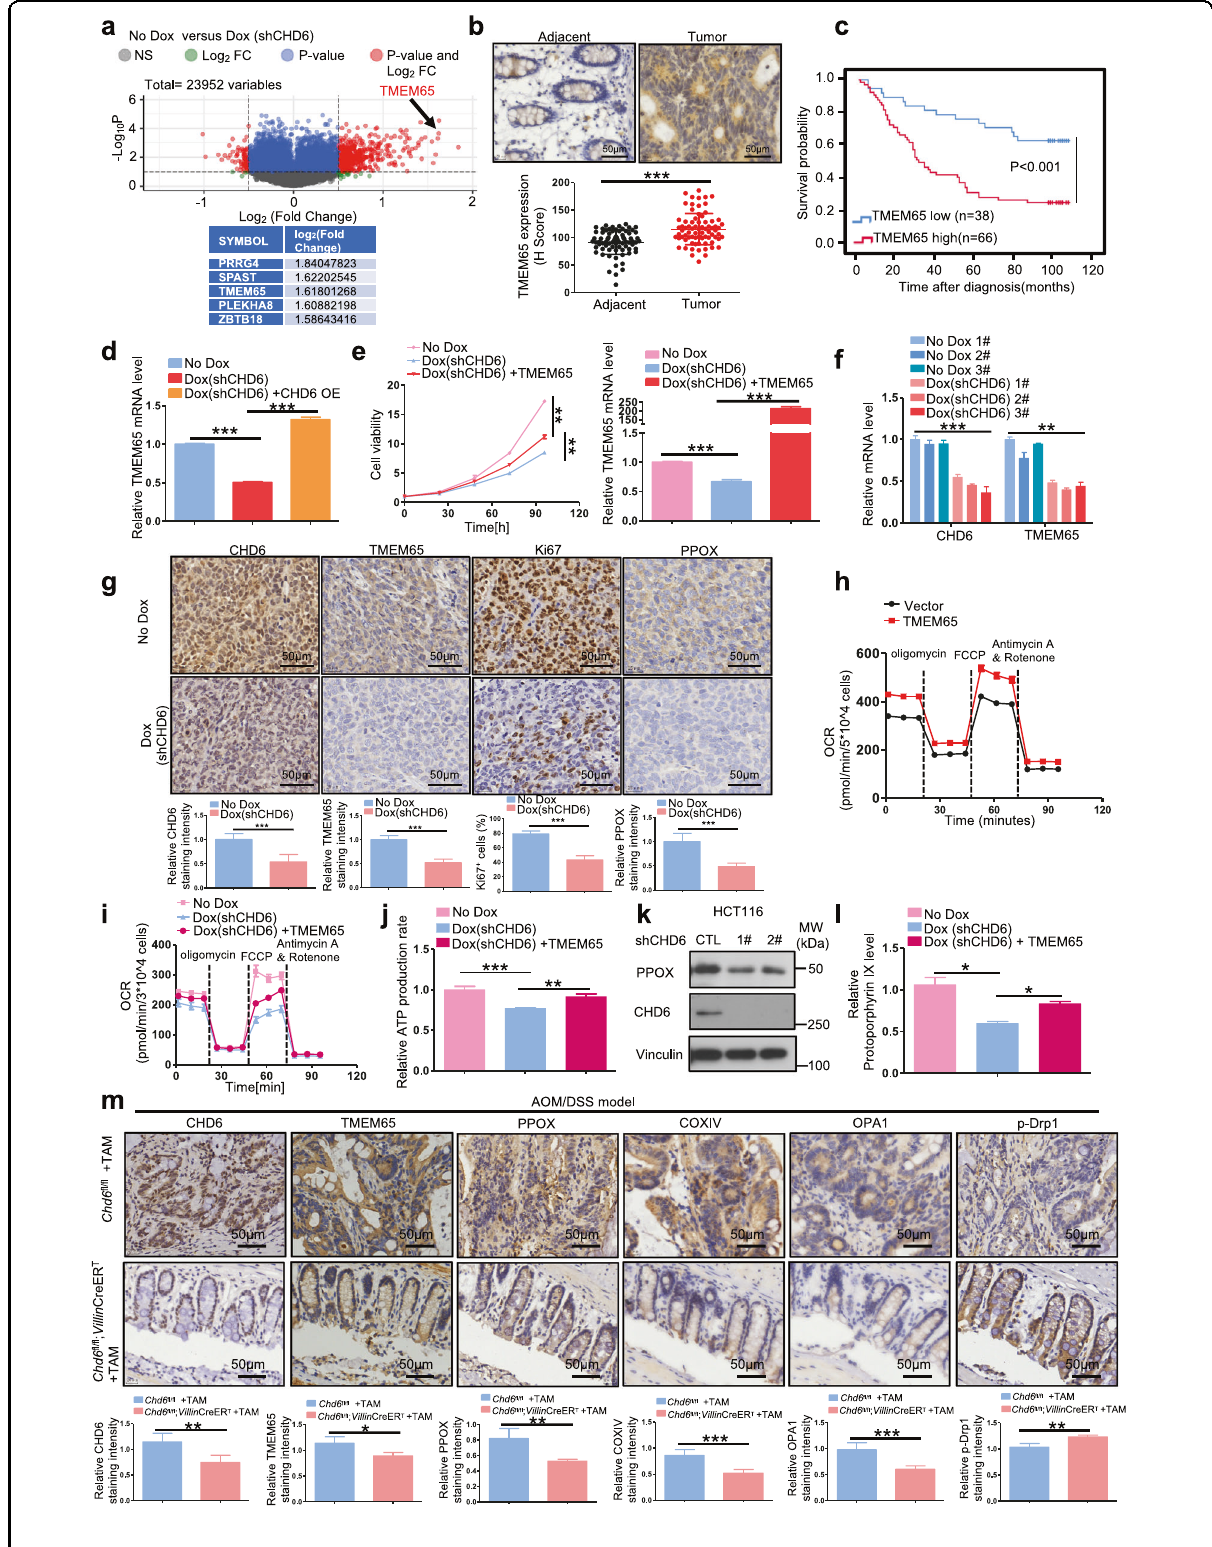
Fig. 5 (See legend on next